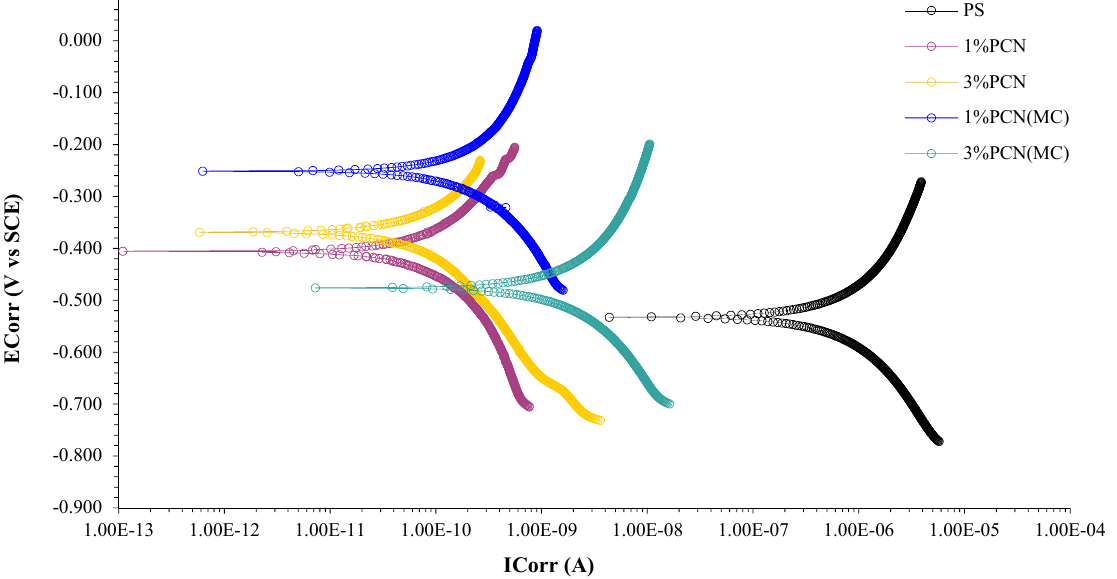
Figure 7. Tafel plots of PS, 1% PCN, 3% PCN, 1% PCN (MC) and 3% PCN (MC) after 1 h of immersion in 3.5 wt.% NaCl at room temperature 20 ± 0.5 °C. Table 5. Tafel parameters of bare C-steel, PS, 1% PCN, 3% PCN, 1% PCN (MC) and 3% PCN (MC)